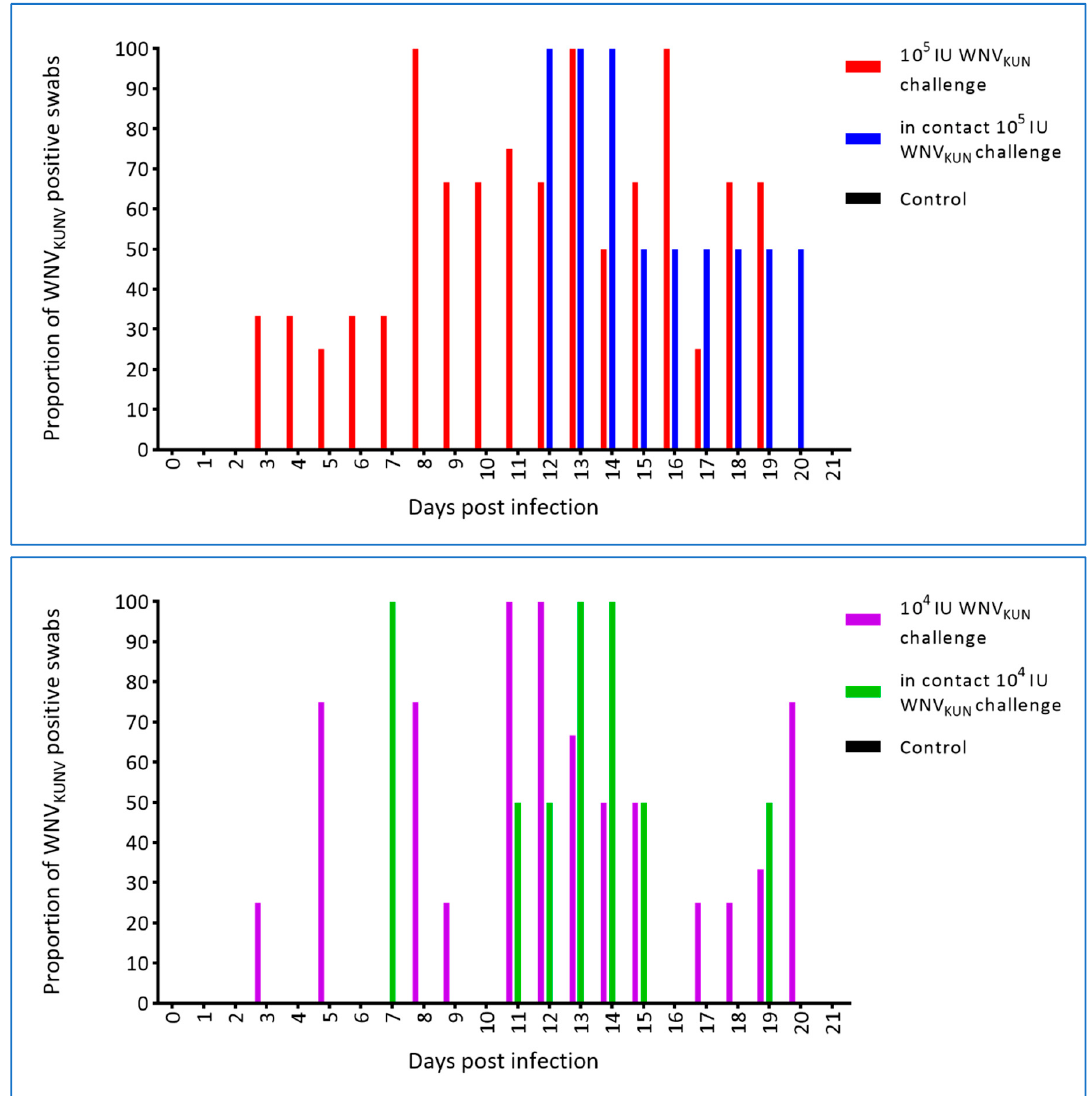
Figure 9. Proportion (%) of oral swabs positive for WNV RNA as determined by qRT-PCR with a cut-off of Ct ≥ 40 [19]. Two in-contact hatchlings and three or four inoculated animals were sampled and tested each day.